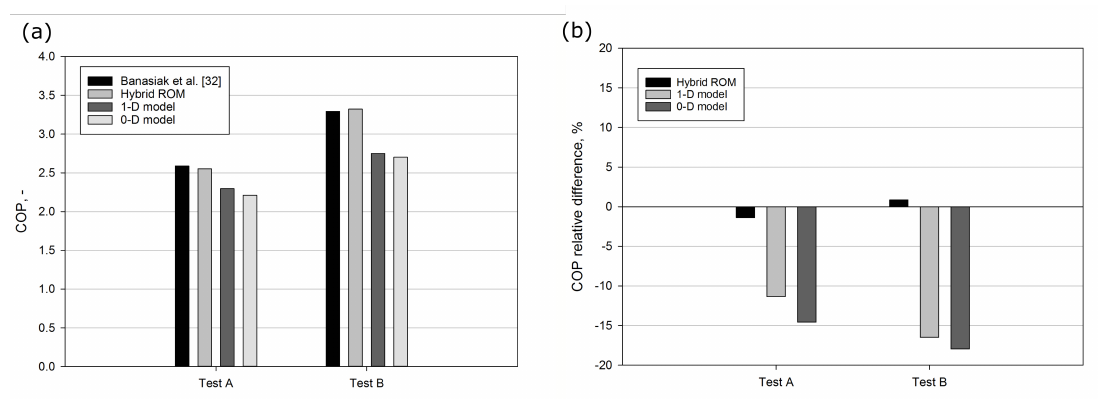
Figure 7. The energy performance of the R744 system based on different two-phase ejector models under the operating conditions given by Banasiak et al. [33]: ( a ) coefficient of performance (COP); ( b ) COP